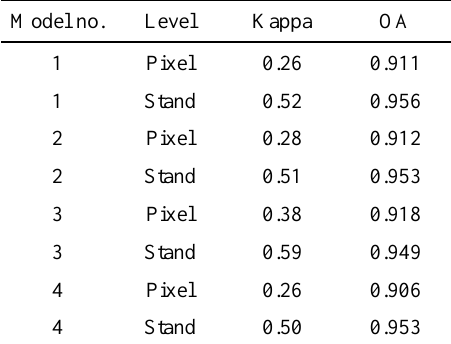
Table 5. The kappa coefficients and overall accuracies (OA) of the best models at the pixel and stand